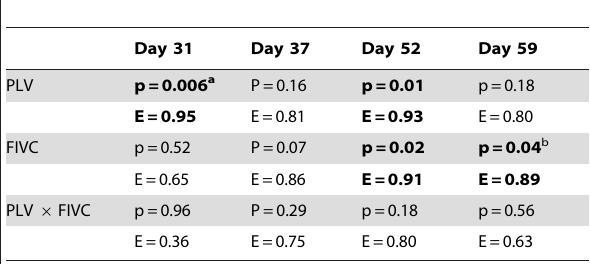
Table 4. Estimated effects (E) and Pillai’s trace p-values (p) for a two-way MANOVA scheme comprising simple and interaction effects of PLV and FIVC, for each day of analysis.